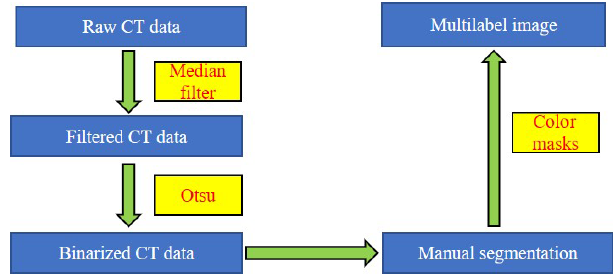
Figure 3. Workflow of the manual semantic segmentation